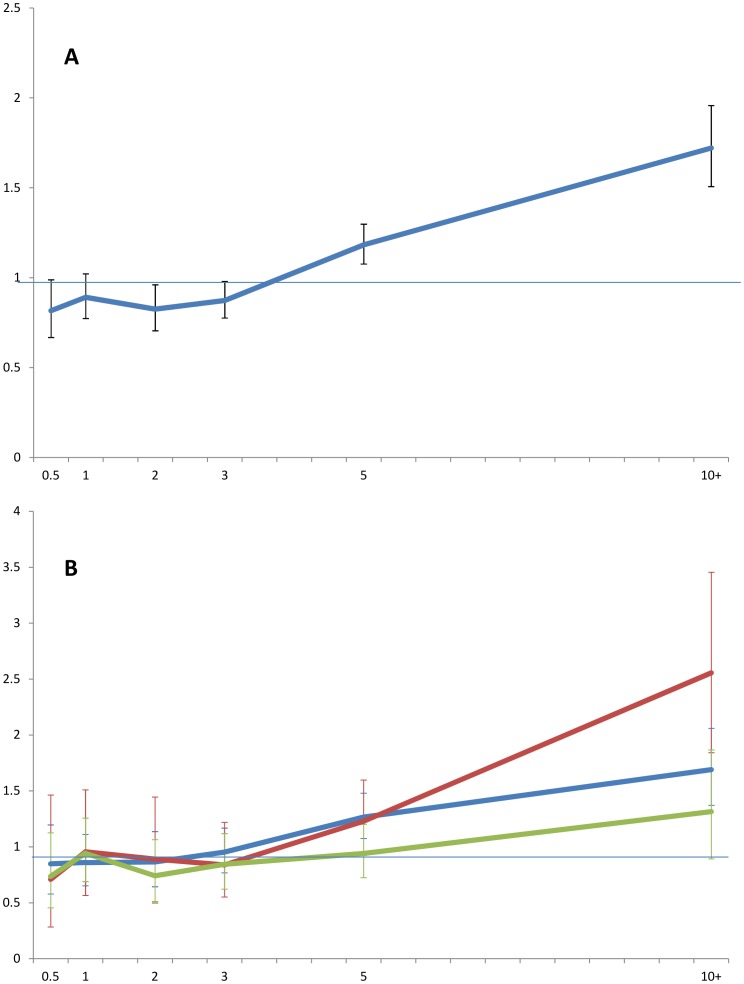
SIR and 95%CI (Y-axis) for all cancers occurring after PCa diagnosis by time (years) since time of PCa diagnosis (A), stratified by treatment (B): surgery (blue), radiotherapy (red), and androgen deprivation therapy (green).